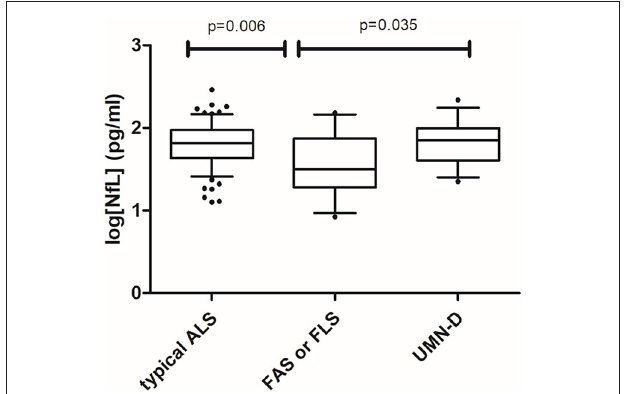
FIGURE 4 | Pairwise comparisons of the typical ALS ( N = 74), flail arm syndrome or flail leg syndrome ( N = 15), and UMND groups ( N = 13) were statistically significant, whereas there was no difference in log[NfL] levels between the typical ALS and UMND ALS groups. One-way ANOVA with post-hoc analysis by Tukey’s multiple comparison